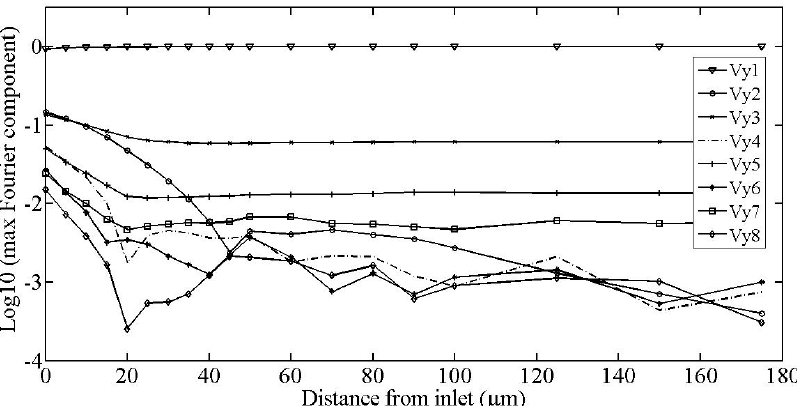
Figure A2. Maximum Fourier components of the vertical velocity components as a function of the distance from the inlet.